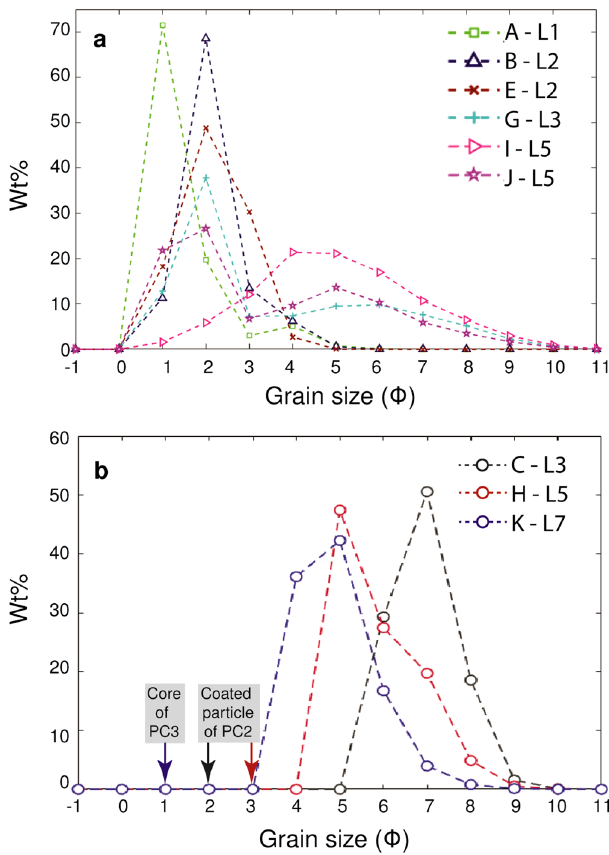
Figure 4. ( a ) GSDs in weight percentage (Wt.%) of tephra collected in trays (bulk samples) representative of the whole time of sedimentation at each location; ( b ) GSD of individual aggregates collected on SEM adhesive tape: coating of two PC2 aggregates from eruption C collected at L3 and eruption H collected at L5 and shell of one PC3 aggregate from eruption K collected at L7. The position of the gray and red arrows indicates the size of the coated particles of eruption C and H (i.e., 325 μm and 158 μm–2 and 3 Φ, respectively) and the blue arrow corresponds to the core of PC3 of eruption K (i.e., 523